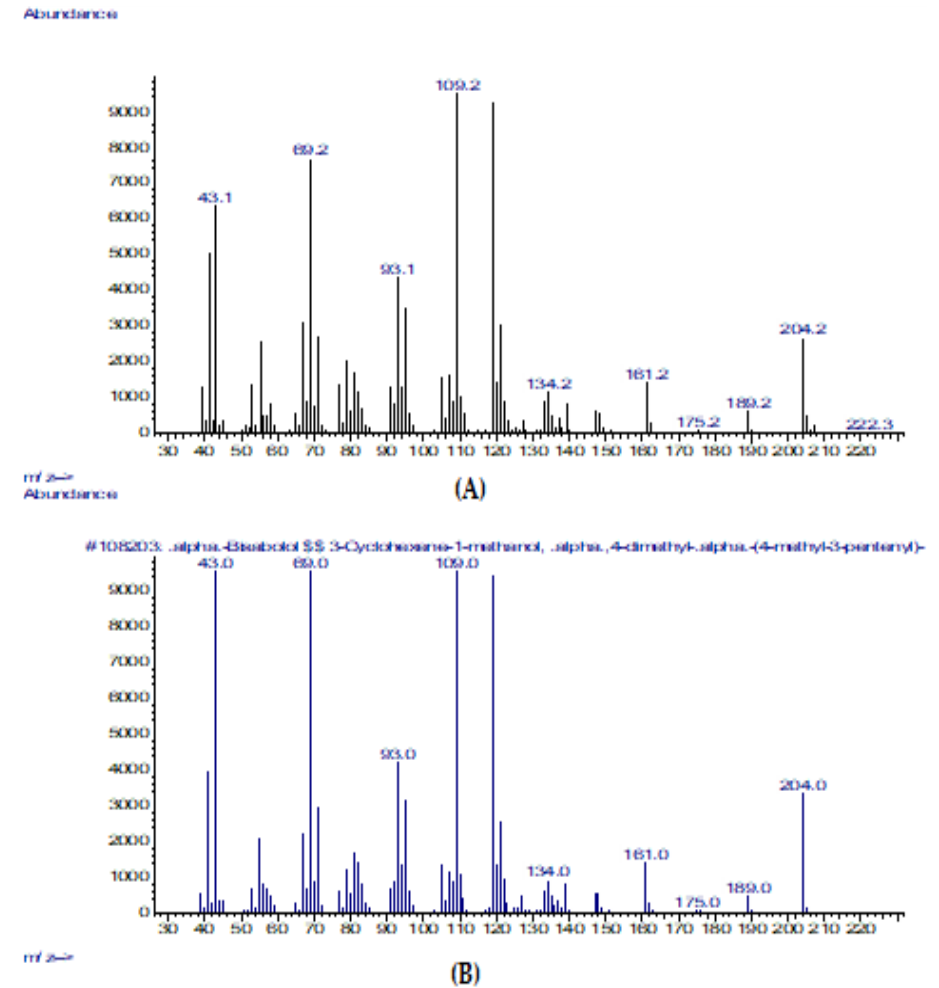
Figure 7. ( A ) Mass spectrum of α -(-)-bisabolol from the plant-based substance (TTO:1,8-cineole: α -(-)- bisabolol in a 1:1:1 ratio); ( B ) Mass spectrum of α -(-)-bisabolol from the NIST-2017 library. Table 2. The plant-based substance The phytoconstituents o- cymene (8.16%), γ -terpinene (6.09%), α -terpineol (2.96%),